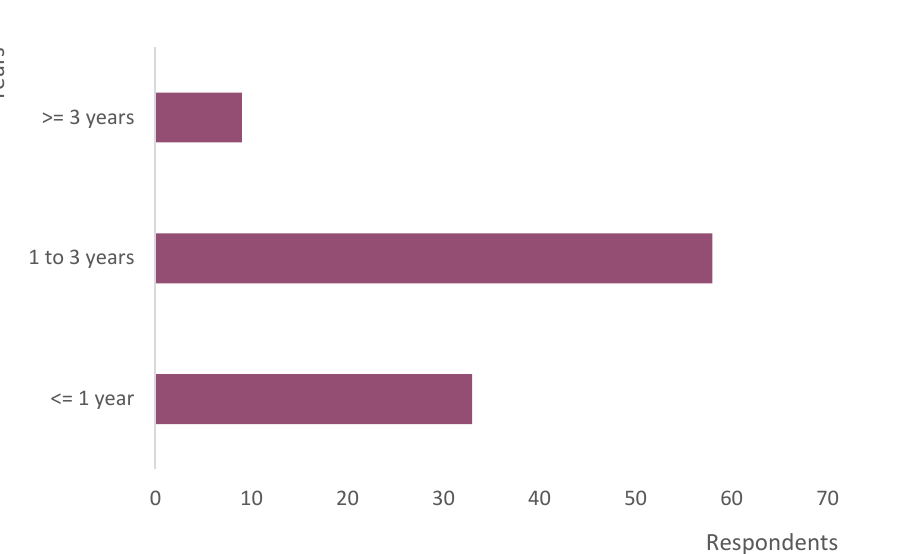
Figure 6. Experience with electric mobility.